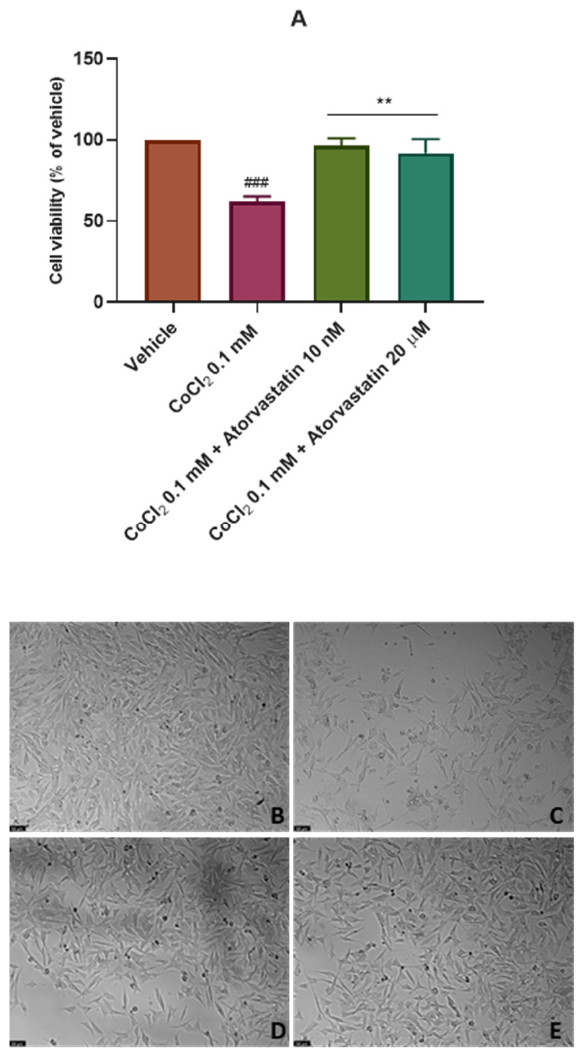
Figure 4. Effect of ( A ) CoCl 2 0.1 mM, CoCl 2 0.1 mM + atorvastatin 10 nM , and CoCl 2 0.1 mM + atorvastatin 20 µ M in SH-SY5Y cellular viability (48 h) obtained by MTT assay, and representative images (100 × total magnification) of these cells after incubation with ( B ) vehicle (sterilized water 2%/DMSO 0.2%), ( C ) CoCl 2 0.1 mM, ( D ) CoCl 2 0.1 mM + atorvastatin 10 nM, and ( E ) CoCl 2 0.1 mM + atorvastatin 20 µ M, after 48 h. Cell viability results are expressed as the percentage of the vehicle (100%). Statistical significance at ### p < 0.001 vs. vehicle and ** p < 0.01 vs. CoCl 2 0.1 mM.